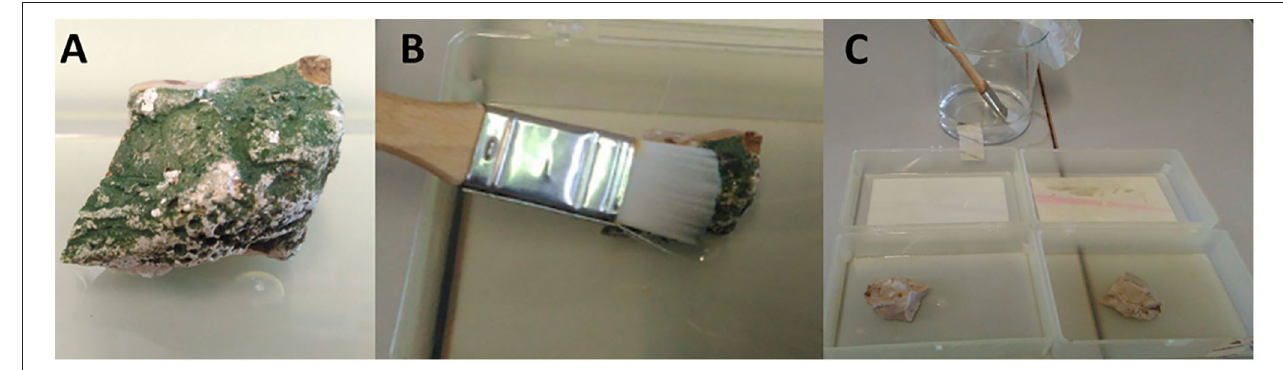
FIGURE 7 | Sample from the Santa Margherita’s cave (A) , treatment with Preventol RI-80 at 10 v / v %. (B) , and application of the CRS (C) .